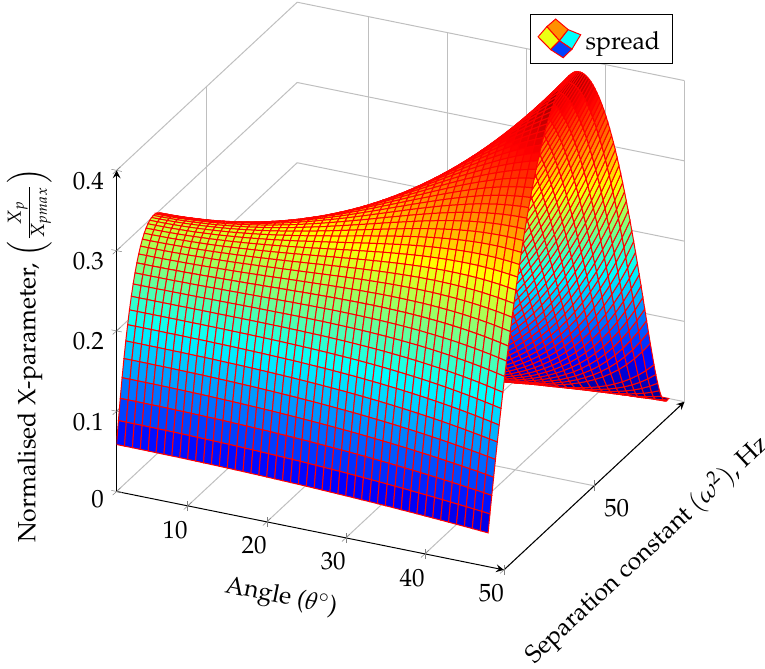
Figure 9. 3 D plot of X-parameter ( X p ) as a function of the separation constant ( ω 2 ) and angle ( θ o ) at time t = 50 d.